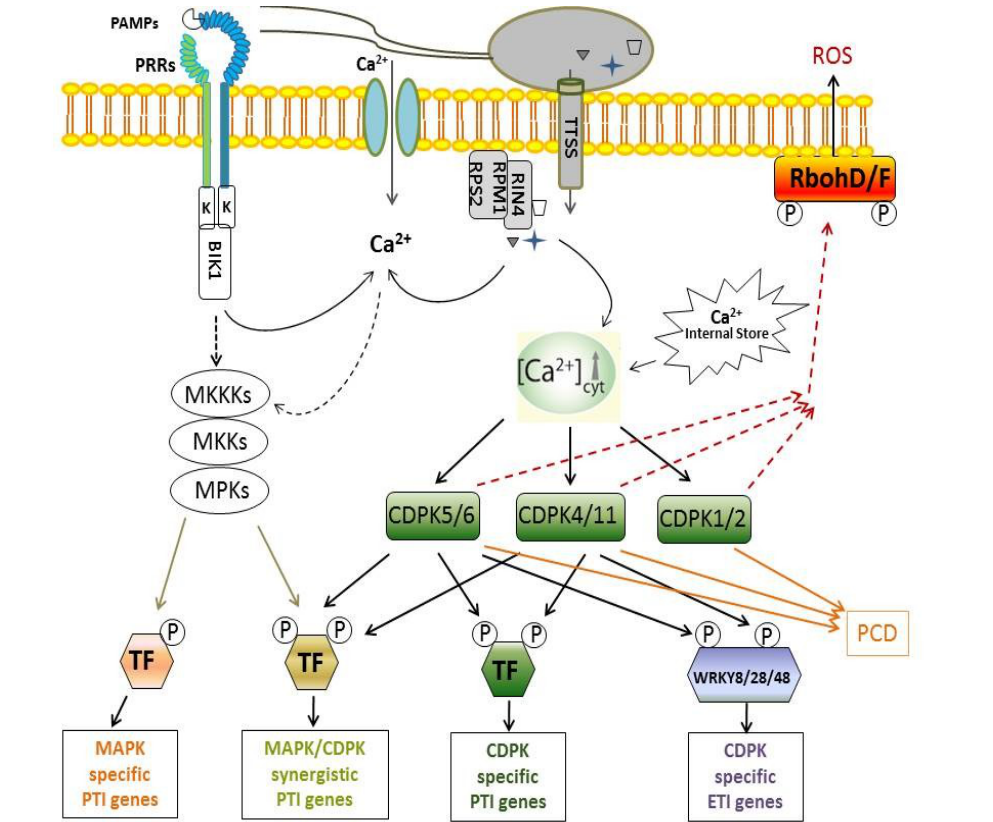
Figure 1. Model of calcium-dependent protein kinase (CDPK)-mediated plant